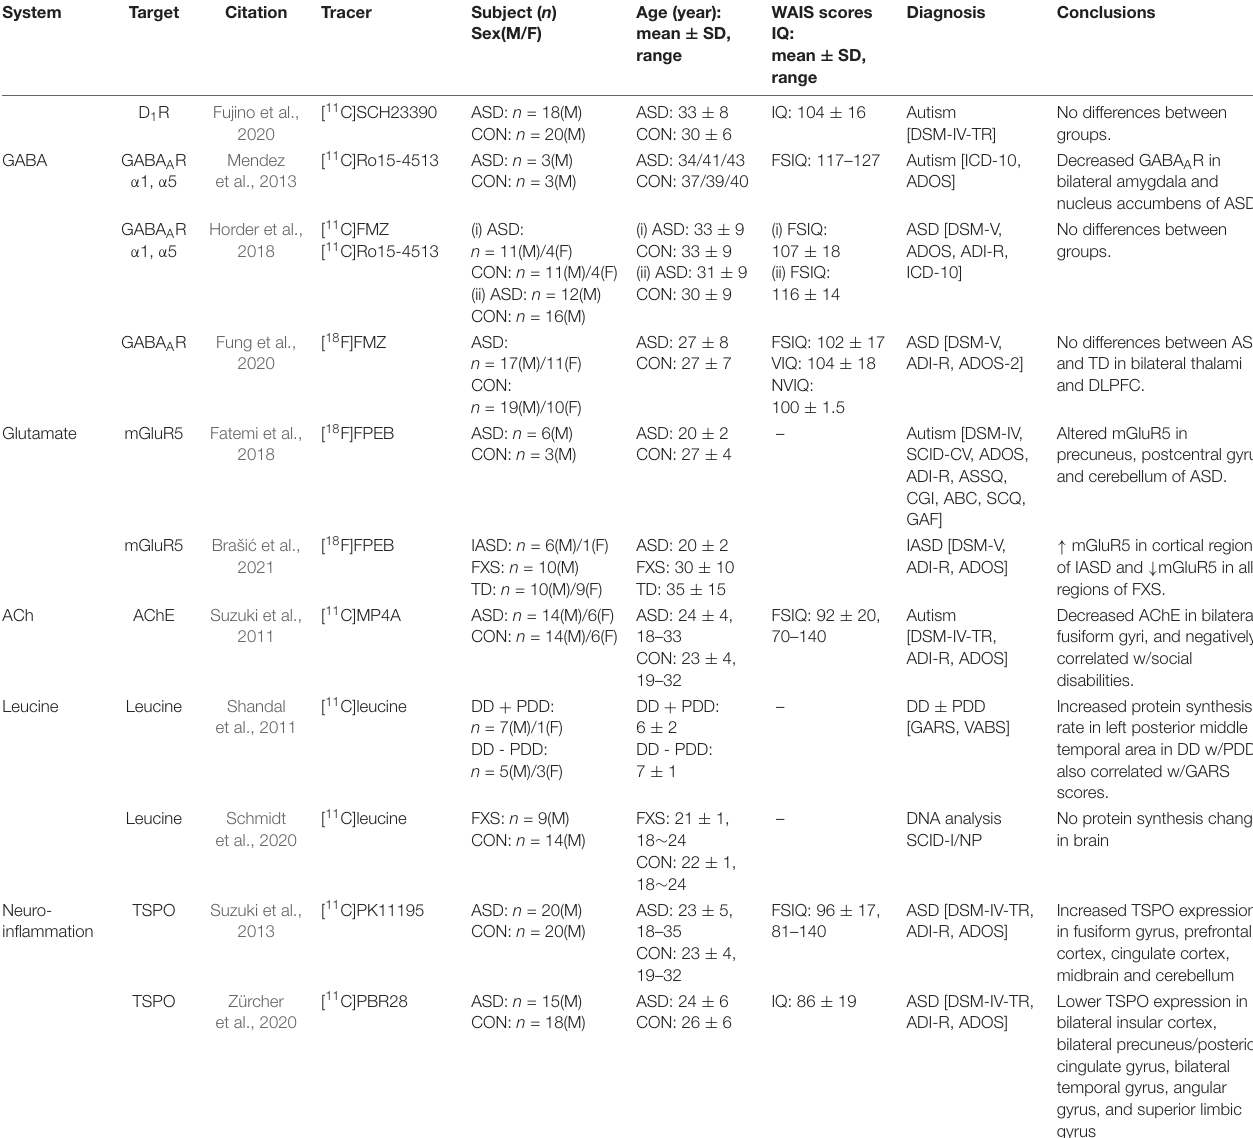
Lower TSPO expression in bilateral insular cortex, bilateral precuneus/posterior cingulate gyrus, bilateral temporal gyrus, angular gyrus, and superior limbic